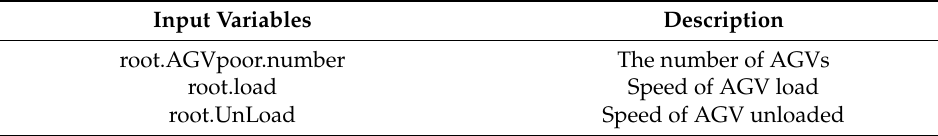
Table 6. Experiment input variables.